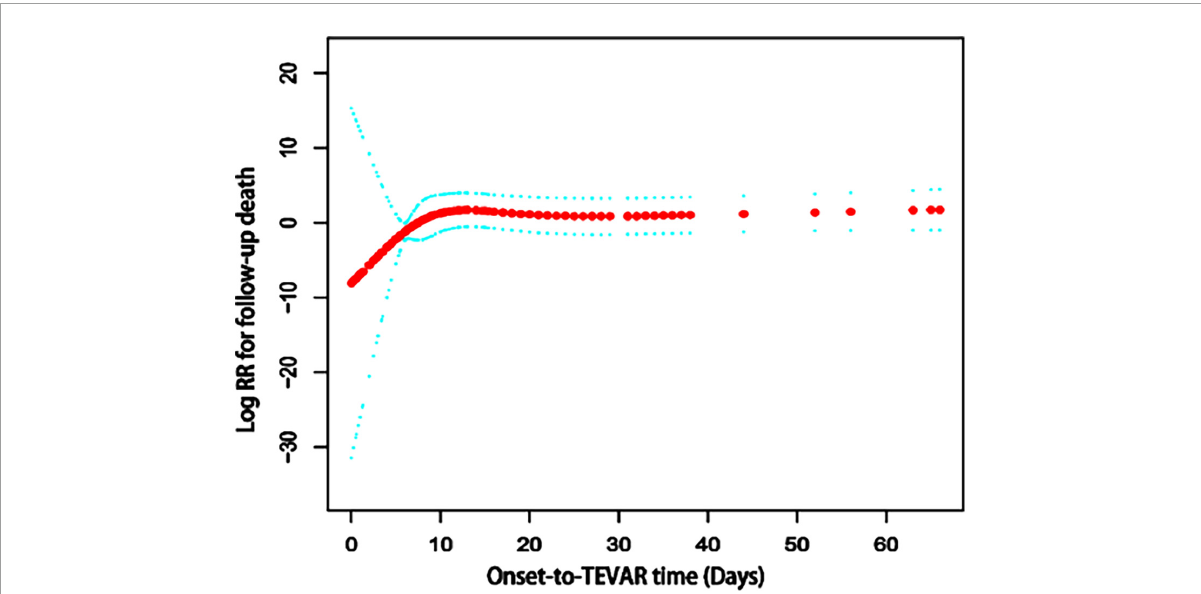
FIGURE3 The spline smoothing plot between onset-to-TEVAR time and follow-up death risk in acute and subacute uncomplicated type B dissection patients who have a history of smoking. The results showed that the curve was elevated in the early stage of the disease, thus the long-term death risk increased with a delay in the onset-to-TEVAR time. When the onset-to-TEVAR time was delayed beyond a specific inflection point (9.4 days), the curve became a near-horizontal state, which indicates that the long-term death risk no longer increased with the delay in onset-to-TEVAR time. RR, Relative risk; TEVAR, thoracic endovascular aortic repair.